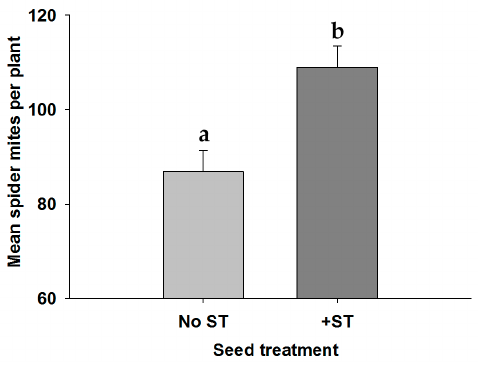
Figure 2. Mean density of spider mites per plant (±SE) at the end of a 6 day greenhouse whole plant experiment on soybean. experiment on